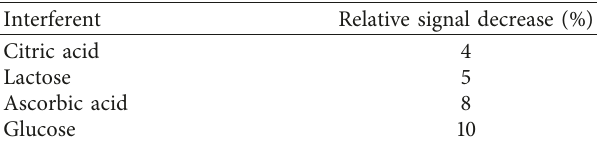
Table 3: Results of interference study.